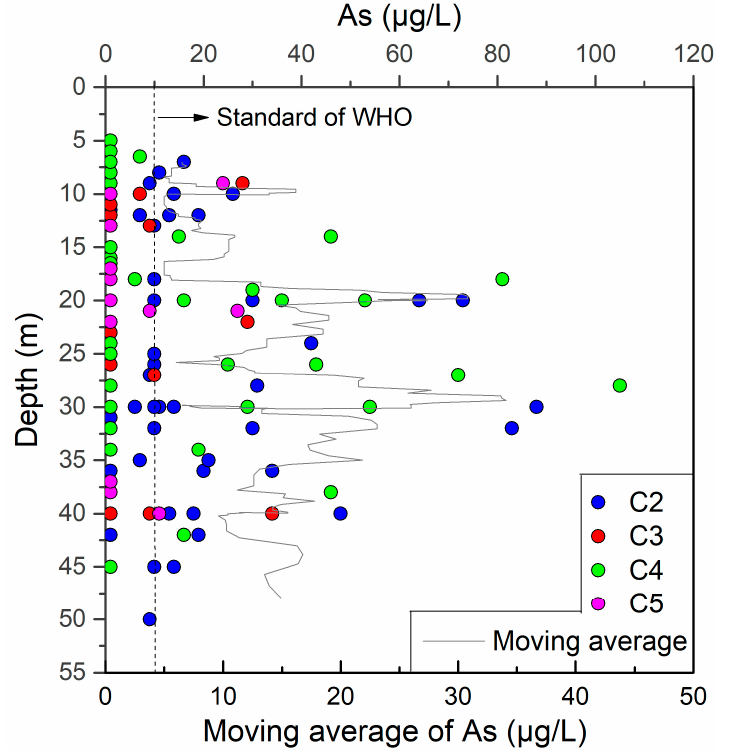
Figure 5. Variations of As concentrations with depth in groundwater. Concentrations were smoothed using a moving average filter with a period of 30.